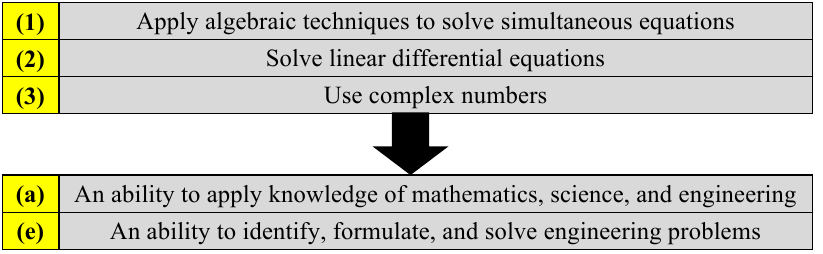
Table 1. Math-related CLOs and their ABET SOs